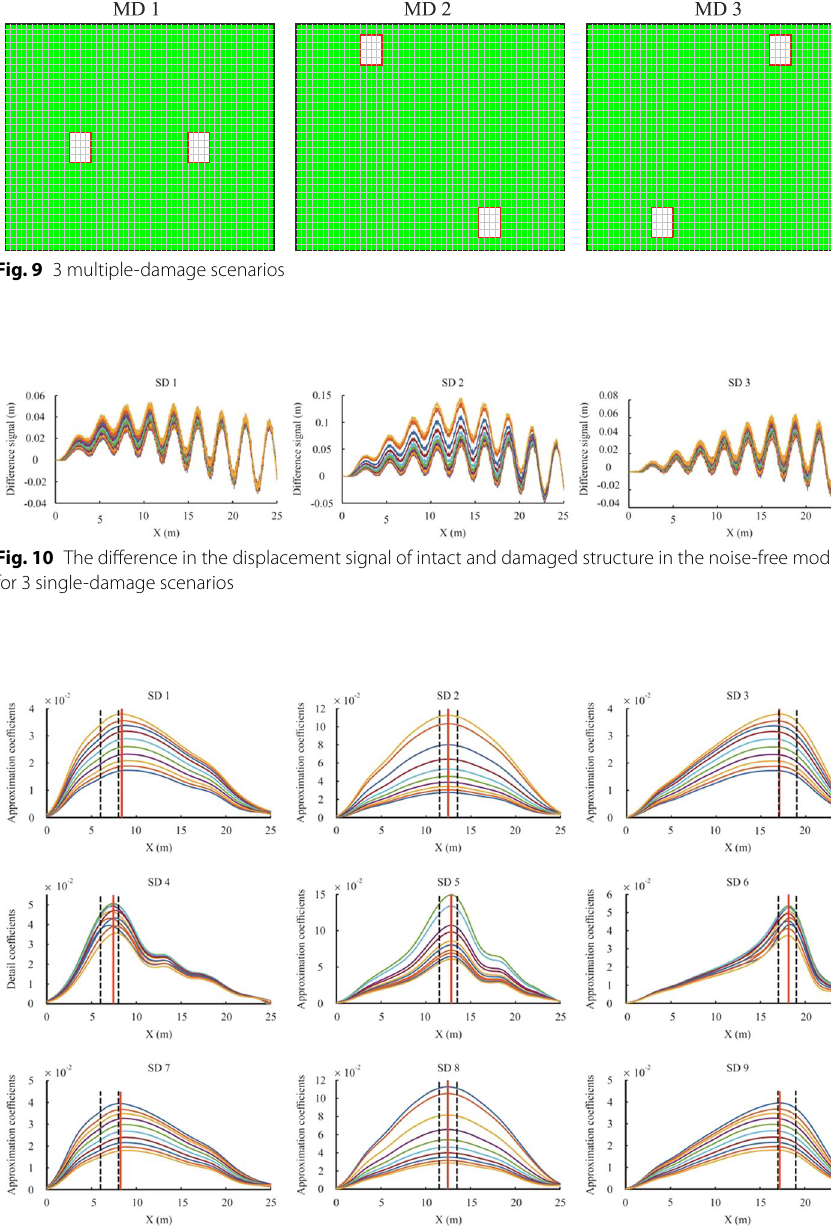
Fig. 11 The ninth order approximation coefficient curve of the signal in the direction of the X axis for 9 single damage scenarios in the noise-free